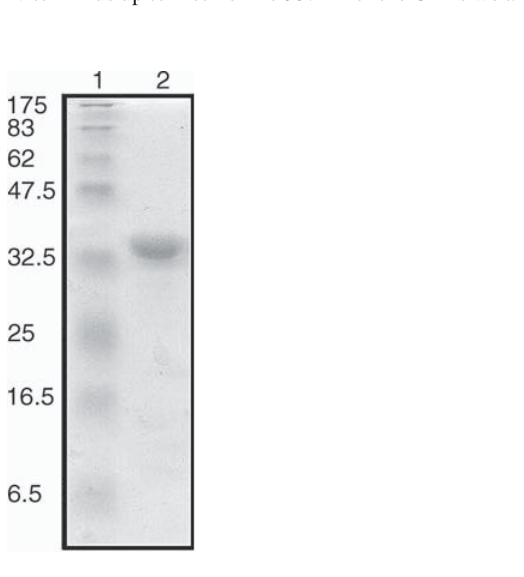
Figure 5. Analysis by SDS-PAGE of Sso N Δ long. Lane 1: molecular mass markers. Lane 2: Sso N Δ long (3 µg)